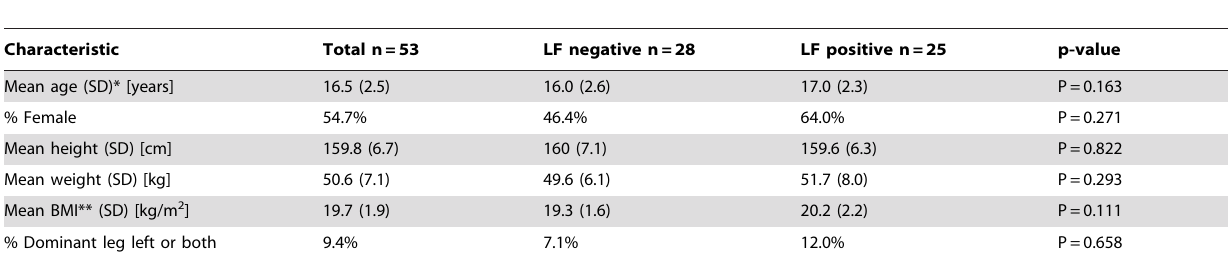
Table 1. Demographics and body characteristics of participants stratified and compared by Lymphatic Filariasis (LF) status.